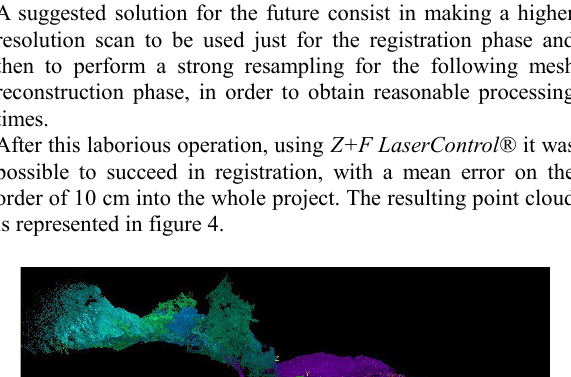
Figure 3. One of the eleven scans in which to detect targets and additional reference points.